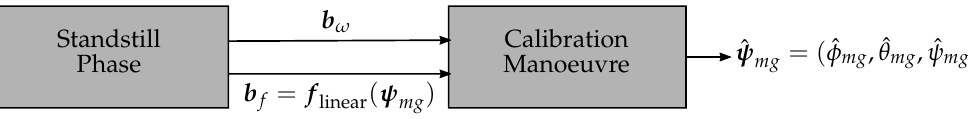
Figure 8. Calibration procedure for the estimation of the misalignment between the ground-truth and IMU coordinate